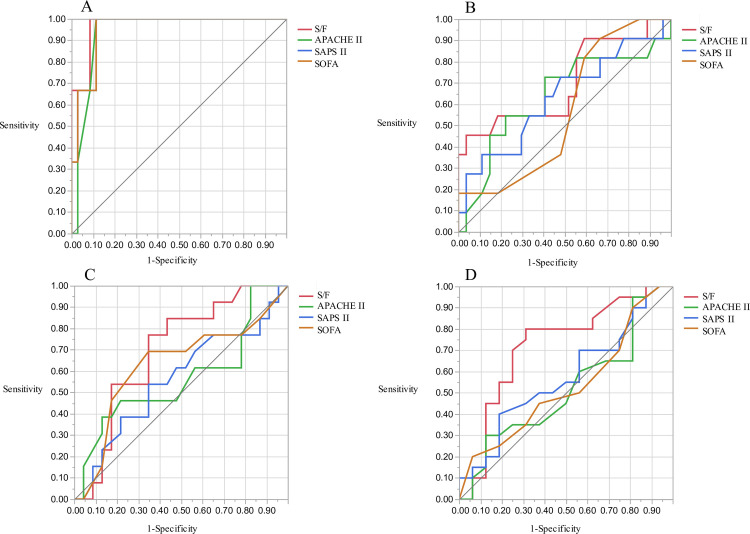
ROC curves for ICU and hospital mortality in bacterial pneumonia and interstitial lung diseases group.In the bacterial pneumonia group, the AUC for ICU mortality was 0.971 (A, 95% CI 0.907–1.000) and for hospital mortality was 0.700 (B, 95% CI 0.493–0.908) using the S/F ratio. In interstitial lung diseases group, AUC for ICU mortality was 0.697 (C, 95% CI 0.520–0.875) and for hospital mortality was 0.720 (D, 95% CI 0.539–0.902) using the S/F ratio.